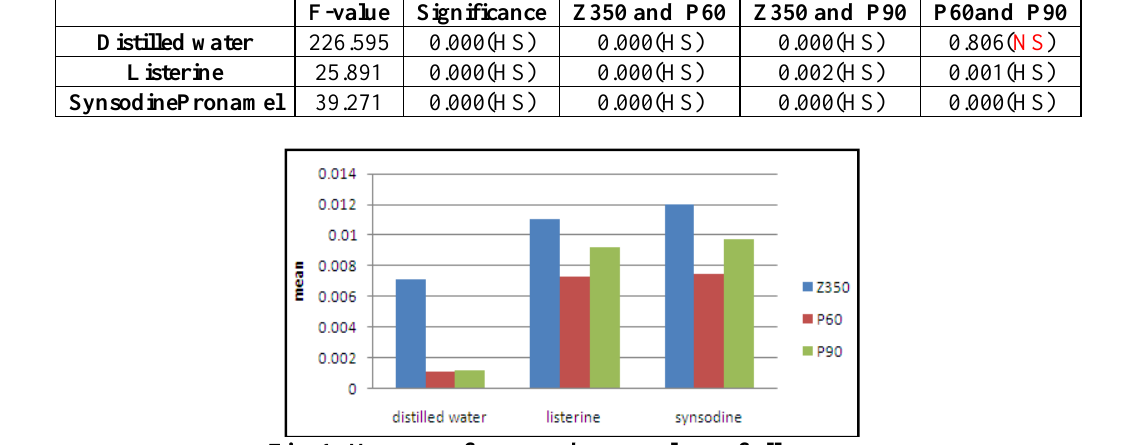
Fig. 1: Mean surface roughness values of all